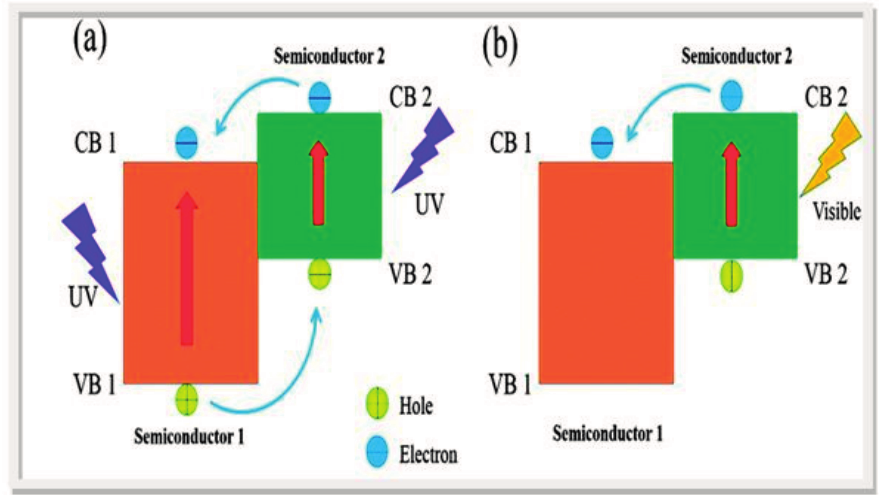
Figure 5. Dual absorbers with complementary bandgap/band edge positions (type II heterojunction) under ( a ) UV; and ( b ) Visible excitation (reproduced from [82] with permission of PCCP Owner